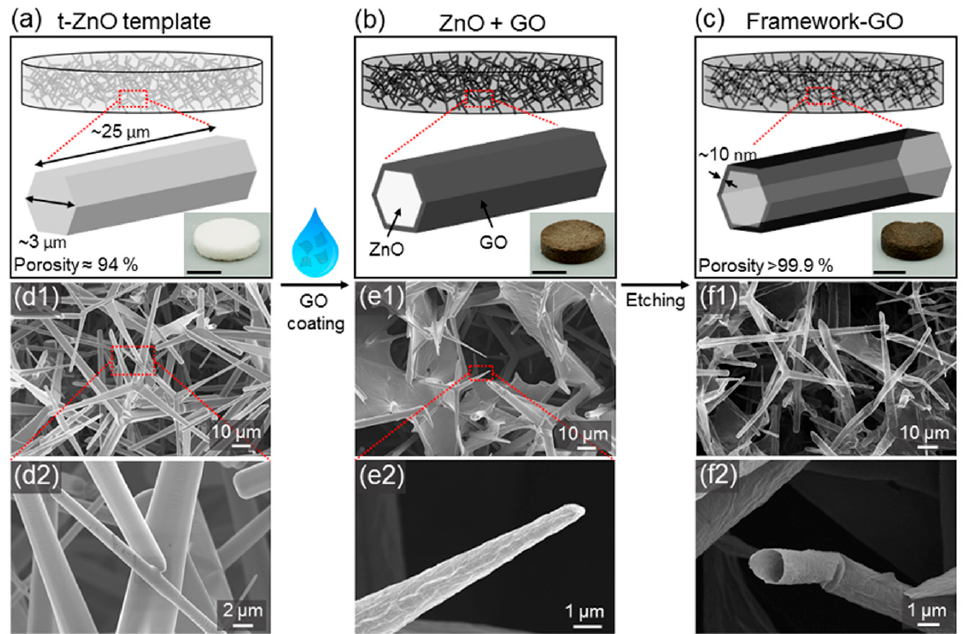
Figure 8. Flow chart of fabrication of graphene oxide framework structures (F-GO). Fabrication steps of graphene oxide framework structures (F-GO): ( a ) schematic of wet chemical assembly of GO into interconnected microtubular structure. ( a ) Sacrificial templates of tetrapodal ZnO are infiltrated with aqueous dispersion of GO flakes resulting in ( b ) a homogeneous coverage of individual ZnO microrods with GO. ( c ) Wet-chemical etching of ZnO leads to a freestanding framework structure of hollow microtubes consisting of GO with a porosity of more than 99%. The insets show photographs of a sample in each production step. Scale bars: 5 mm. ( d – f ) SEM micrographs of ( d ) network of tetrapodal ZnO, ( e ) ZnO tetrapods covered with GO, and ( f ) framework structure of hollow GO